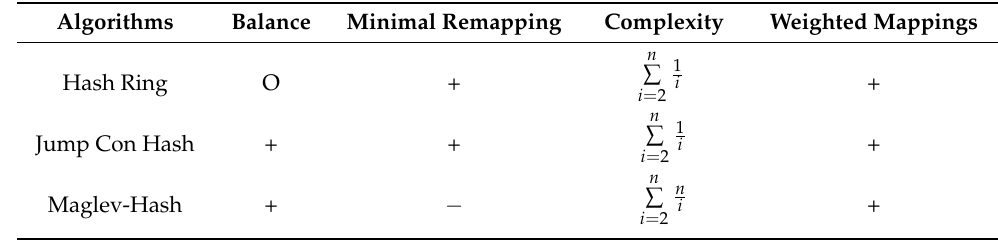
Table 1. Performance comparison of existing consistent hash algorithms. Algorithms Balance